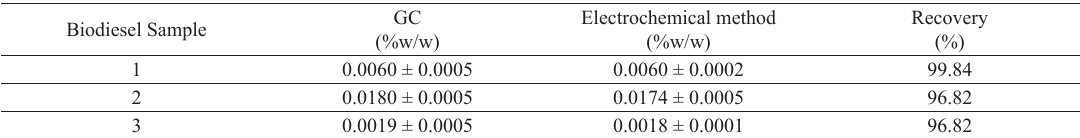
Table 3. Comparison of free glycerol concentration in biodiesel samples obtained by CG and the electrochemical method proposed here. Biodiesel